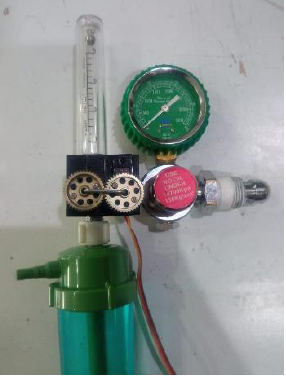
Figure 13 . Mechanical implementation in regulator.